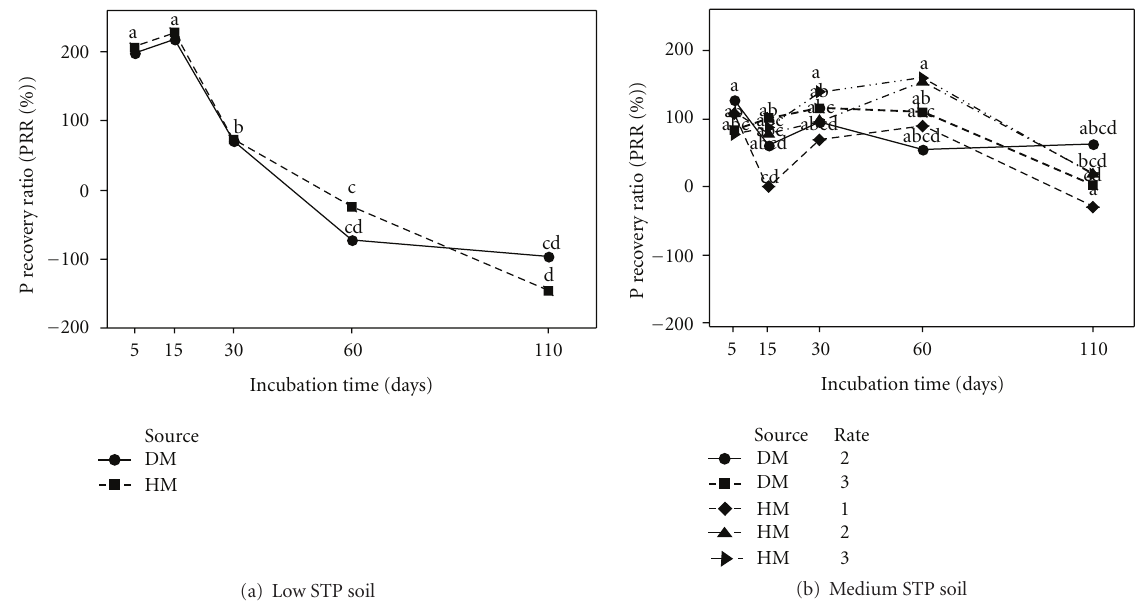
Figure 1: % P Recovery Ratio (%PRR) for the two sources of manure (low-STP soil) and the five combination of source of manure and application rate (medium-STP soil) at the five incubation periods. Within each soil, means sharing the same letter are not significantly di ff erent.